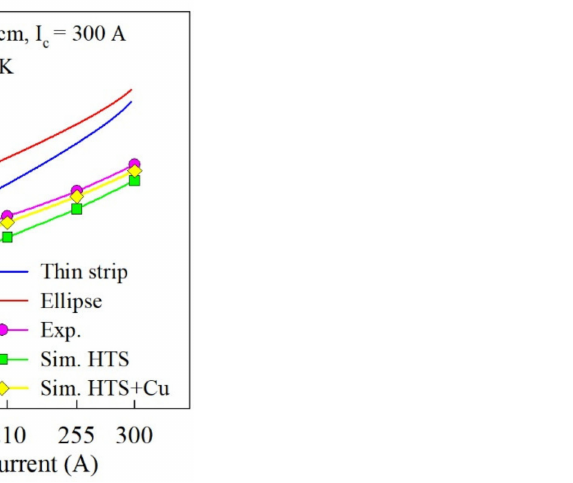
Figure 10. Comparison between experimental and simulation values of AC loss of 2 mm − 7 −